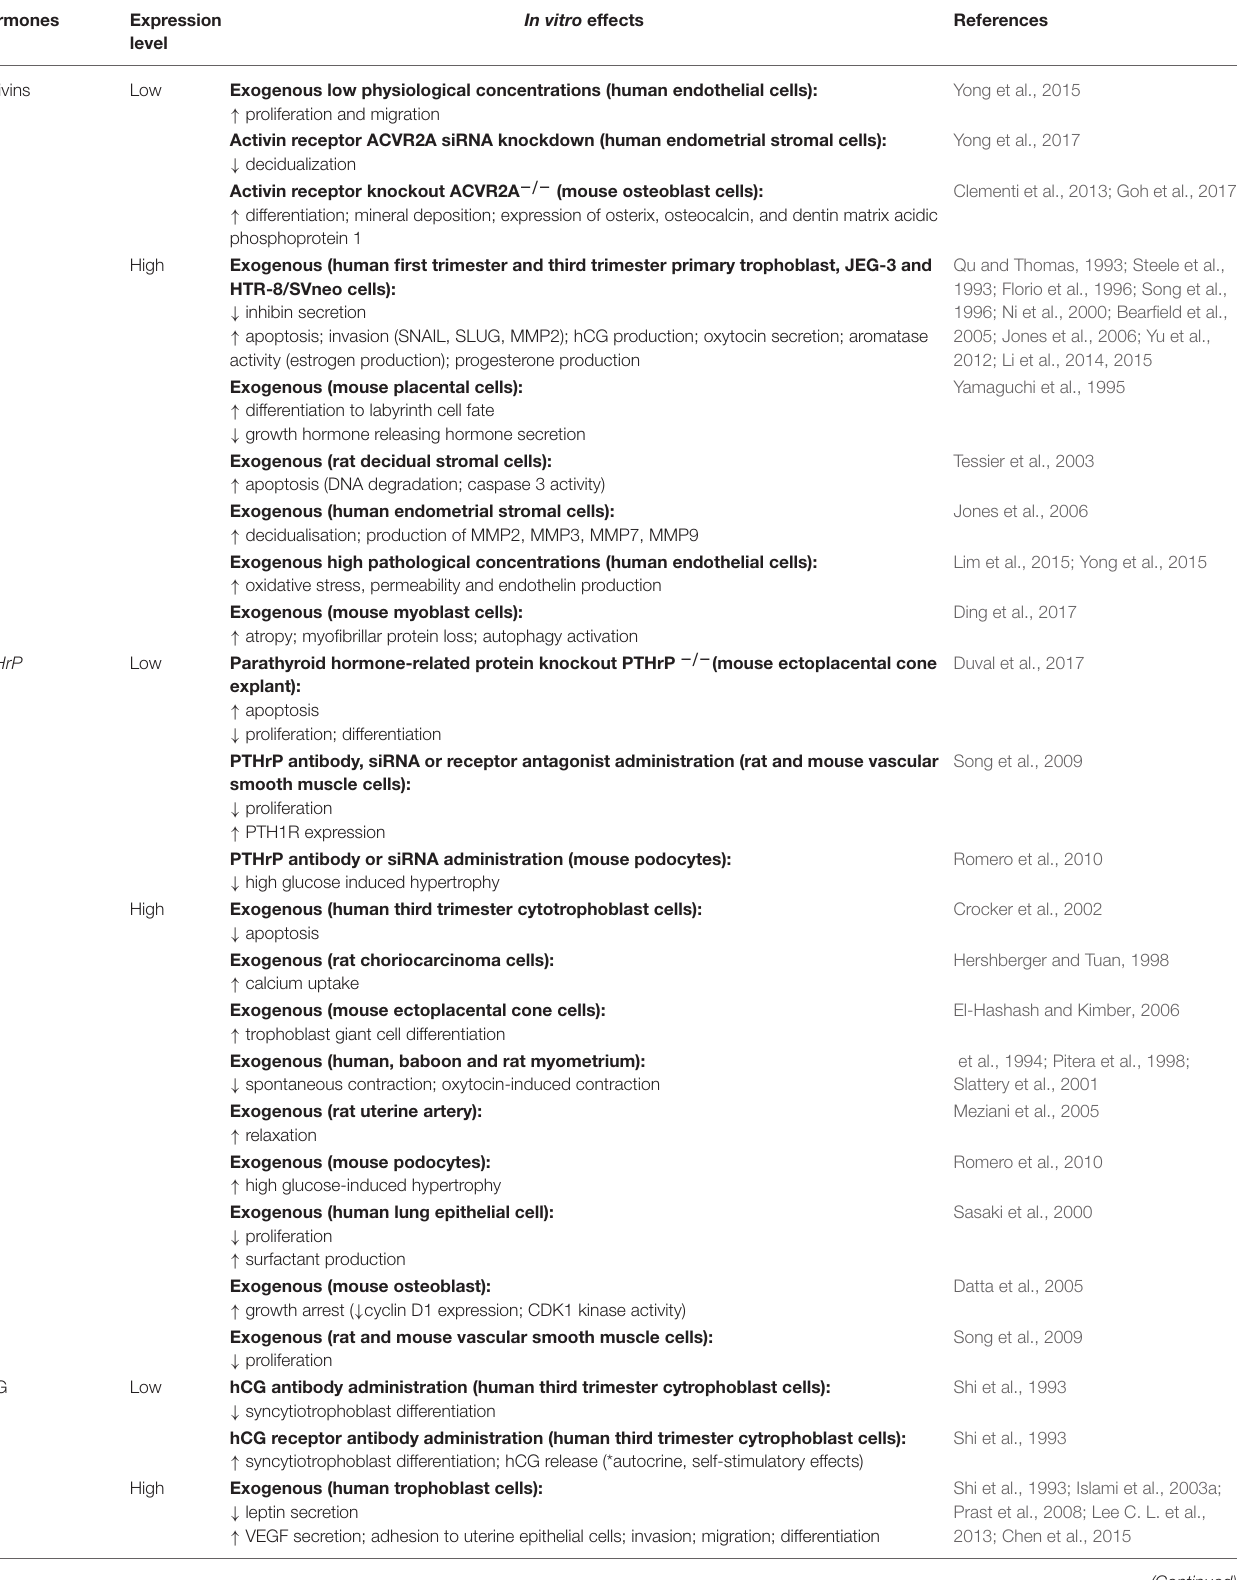
TABLE 8 | Effects of additional hormones in vitro